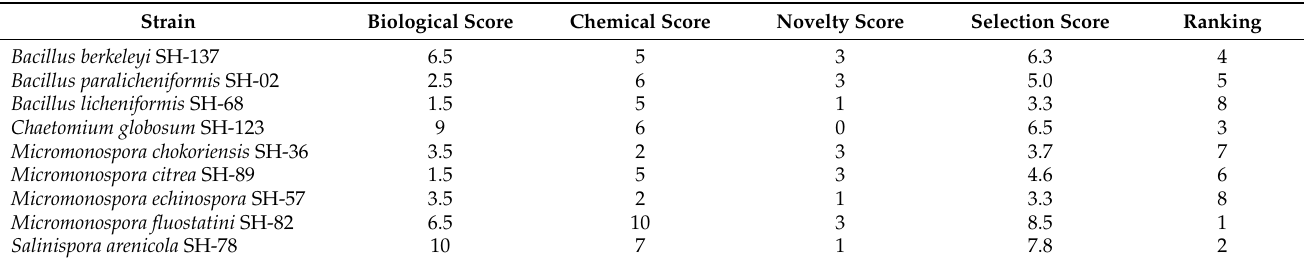
Table 5. Synthesis of the scores attributed to each of the 9 microbial strains and general ranking based on chemical, biological and novelty